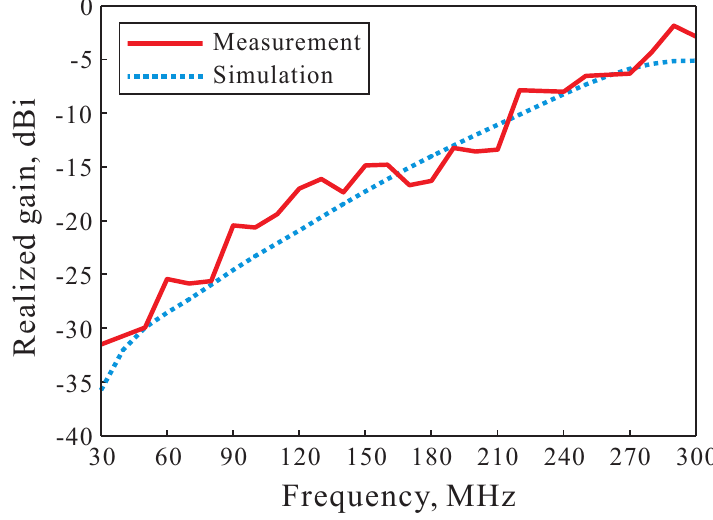
Figure 7. Simulated and measured realized peak gains of the proposed antenna on the xz -plane. Simulated and measured radiation patterns at 60, 180, 300 MHz on two planes ( xz -plane and yz -plane) are shown in Figure 8. The simulated and measured results are indicated by the dashed and solid lines, respectively. The radiation patterns of the proposed antenna are omni-directional at all frequencies. The feeding location is tilted toward the + x -axis relative to the center of the antenna, resulting in some asymmetry patterns. The differences between the simulated and measured results arose due to the weather at the measurement center, manufacturing uncertainties, and similar